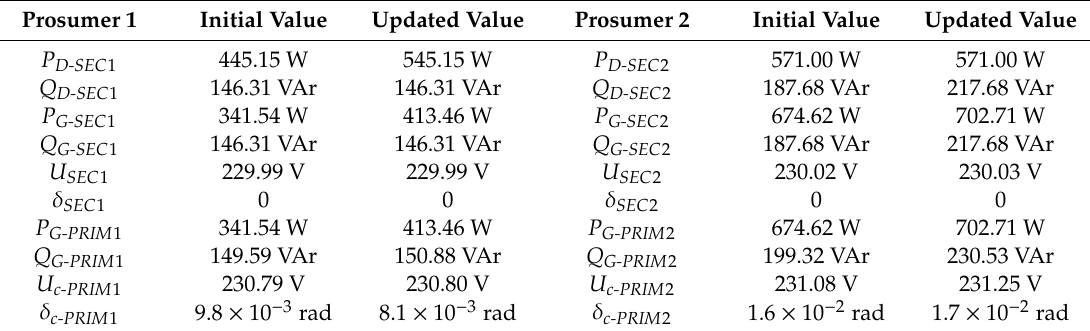
Table 3. Initial and updated power and voltage setpoints from secondary